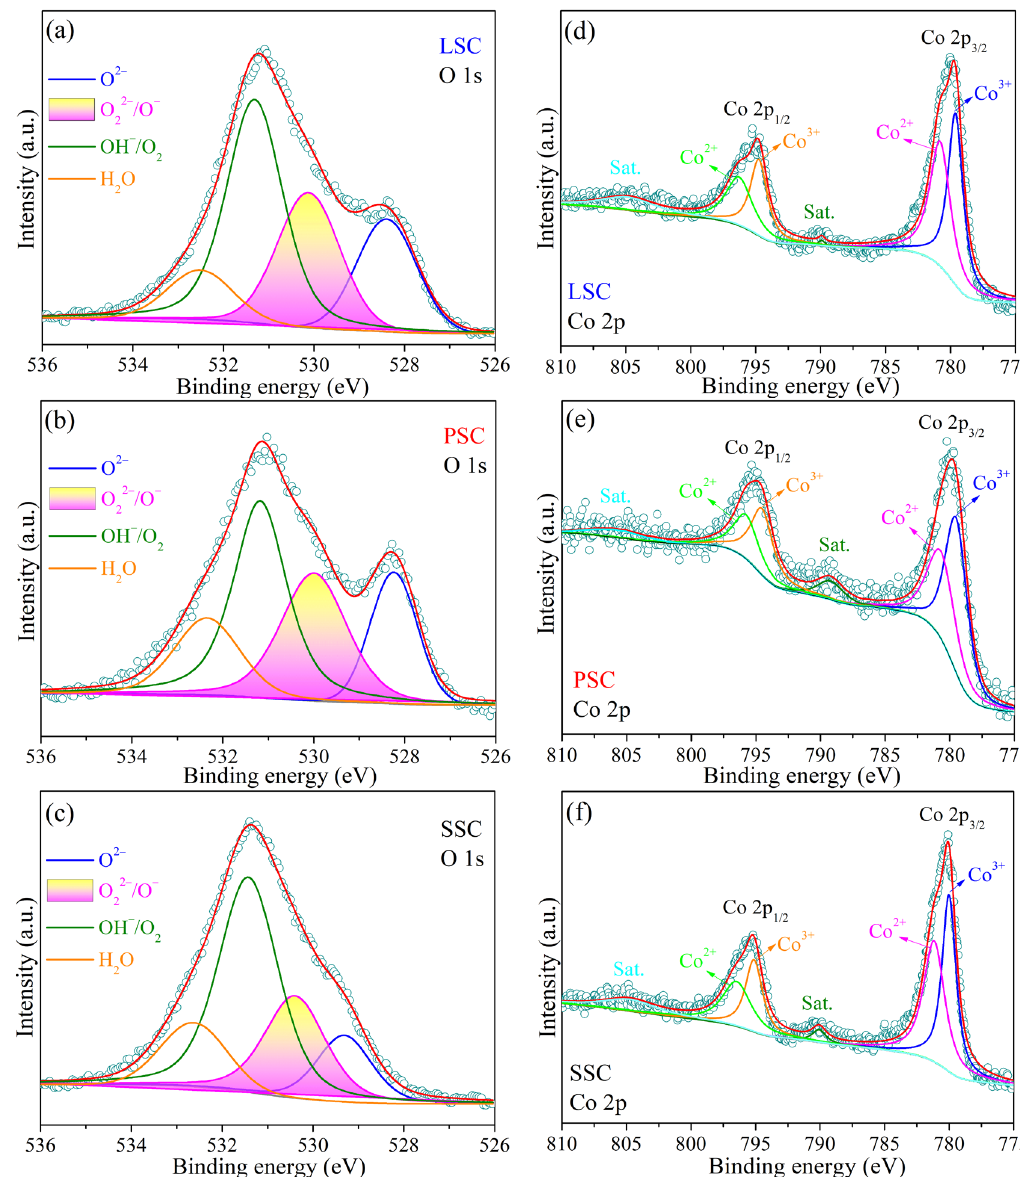
Figure 3. XPS high-resolution spectra of the O 1s ( a – c ) and Co 2p ( d – f ) for LSC, PSC and SSC. Red lines and circles—spectra before deconvolution.